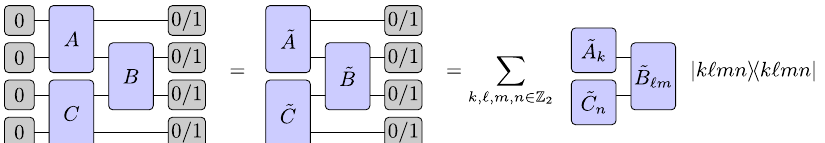
Fig. 3 Fragment recombination as a tensor network contraction problem. The full probability distribution over measurement outcomes for a circuit reconstructed from fragments A , B , C can be represented by a tensor contraction of the reduced states ~ A ; ~ B ; ~ C , obtained by performing MLFT on the fragments. The probability to measure a given bitstring k ℓ mn (i.e., a concatenation of k ;‘; m ; n 2 Z 2 ) on the output of the fragment is given by the contraction of the diagonal blocks ~ A k ; ~ B ‘ m ; ~ C n . The lack of classical inputs to fragment B implies that ~ B ¼ B